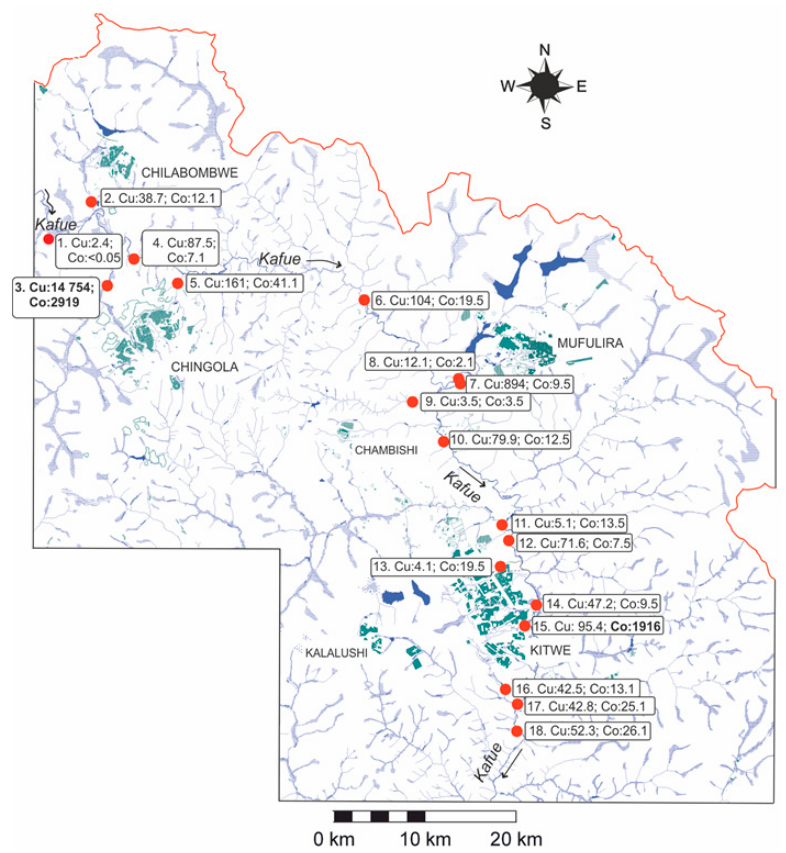
Figure 12. Concentrations of Cu and Co in the water of the Kafue River Catchment, Zambian Copperbelt Mining districts. Concentration in μ g/L, filtered water. Sampling campaign 2008 and 2009, average data. Values exceeding the water effluent discharge limit in Zambia are printed in bold. Sampling sites description: 1. An inflow of the Kafue River to the Copperbelt area (reference point of the non-contaminated Kafue); 2. Lubengele River, tributary of the Kafue River from the Chililabombwe industrial area; 3. Mushishima River polluted with washed-out material from old flotation tailings south of Chingola re-processed through chemical leaching plant, tributary of the Kafue River; 4. Kafue River, after junction with contaminated Mushishima and Chililabombwe rivers; 5. Changa River, contaminated with overflow from the Chingola KCM thickeners. Tributary to the Kafue River; 6. Kafue River, after passing through the Chingola industrial area; 7. Mufulira River, tributary to the Kafue from an area of large tailing ponds south of Mufulira; 8. Kafue River, after junction with the Mufulira River; 9. Musakashi River, tributary to the Kafue River from an area of large tailing ponds north of Chambishi Town; 10. Kafue River, middle stream; 11. Mbabwashi River, tributary to the Kafue River from an area of large tailing ponds south of the Chambishi Town; 12. Kafue River, middle stream; 13. Mindolo River, tributary to the Kafue River from an area of tailing ponds of the Mindolo Mine; 14. Kitwe River, flowing through the waste dumps area west of Kitwe; 15. Uchi River polluted with industrial water released from the Nkana Smelter and Chemical Plant. Tributary of the Kafue River; 16. Wusakile River, tributary to the Kafue River from an area of the Nkana Industrial Complex; 17. Kafue River after passing the Kitwe industrial area; 18. Kafue River, outflow from the Copperbelt industrial